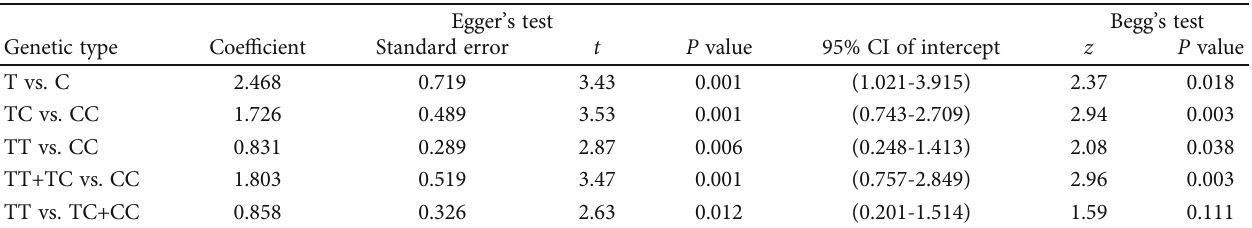
Figure 9: (a) Begg ’ s funnel plot for publication bias test (T-allele vs. C-allele). (b) Egger ’ s publication bias plot (T-allele vs. C-allele). (c) Sensitivity analysis (T-allele vs. C-allele). Table 3: Publication bias tests (Begg ’ s funnel plot and Egger ’ s test for publication bias test) for MTHFR gene rs1801133 polymorphism and essential hypertension